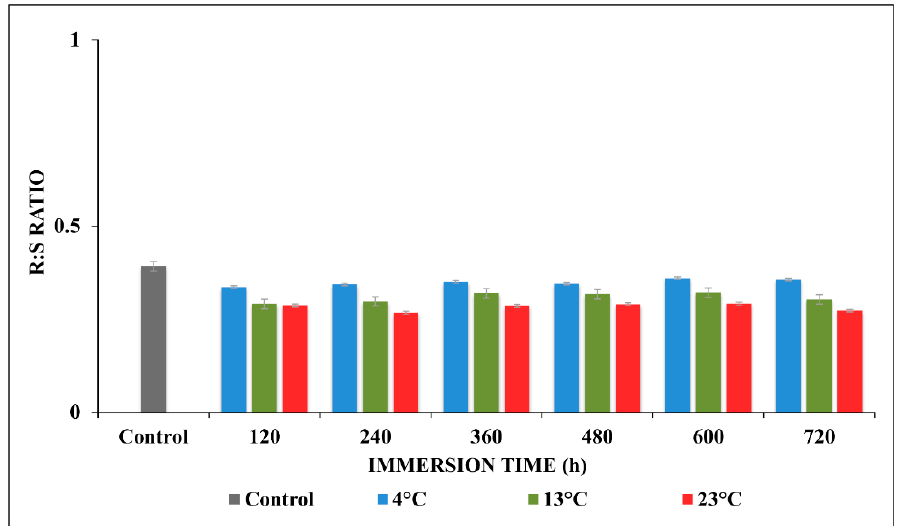
Figure 4. Effects of sea water submergence on the root mass to shoot mass ratio (R:S ratio) (means ± S.E.). Control presents R:S ratio of the untreated rhizomes, others represent data for those treated with sea water replicates.